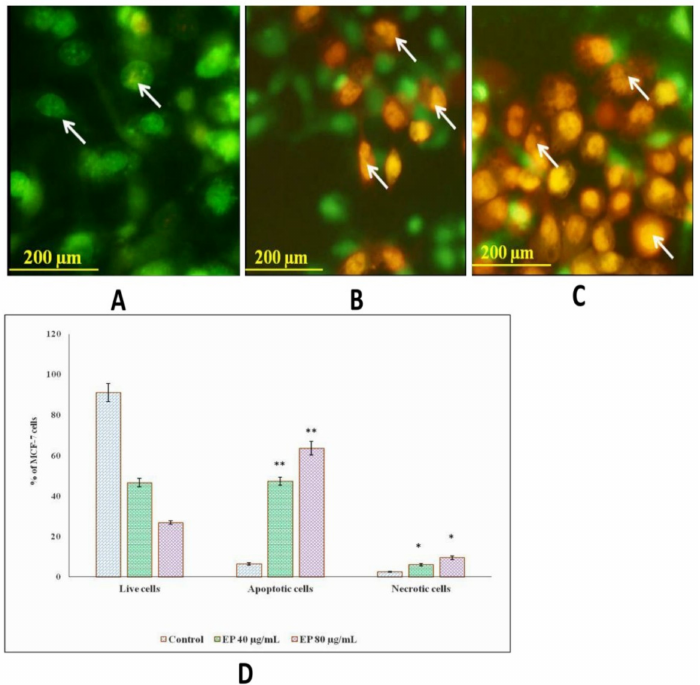
Figure 6. Effect of EP on apoptotic morphological changes in microscopic observation of MCF-7 cell line. The cells were treated with AO/EtBr and visualized under fluorescent microscope. ( A ) Control cells, ( B ) Treated with EP (40 µ g/mL), ( C ) Treated with EP (80 µ g/mL, ( D ) Experiments were performed in triplicates. The results are expressed as mean ± SD. Significant difference between treated and control group given as *( p < 0.05) ** ( p <